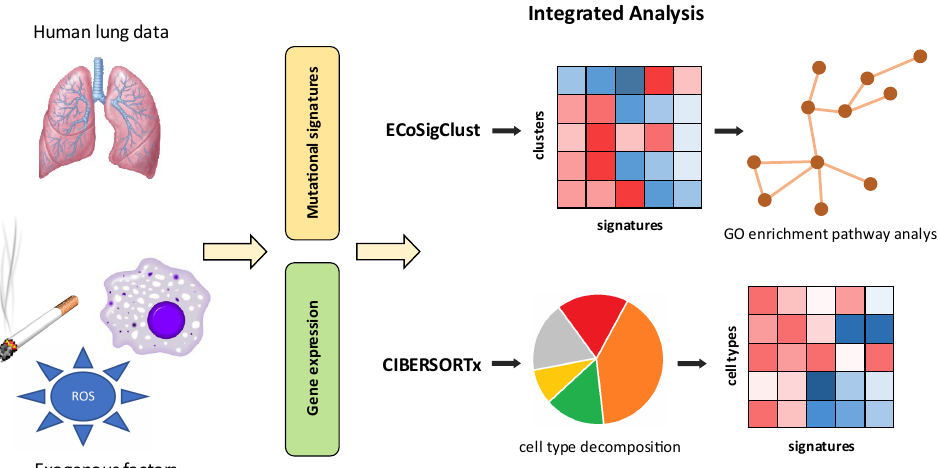
Figure 1. The analysis overview of the impact of smoking and exogenous processes on non-neoplastic lung tissue.Given a tumor and control sample from the same patient, the tumor sample is used as a readout of mutational signatures, while the control sample is used as a readout of changes in gene expression in non-neoplastic control as a function of mutation signature exposure. The combined analysis of mutational signatures and gene expression with ECoSigClust uncovers functional changes in gene expression ( upper panel ), while the analysis of these signatures leveraging CIBERSORTx uncovers changes in cellular composition ( lower panel ) and sheds light on their correlation with exposures to exogenous